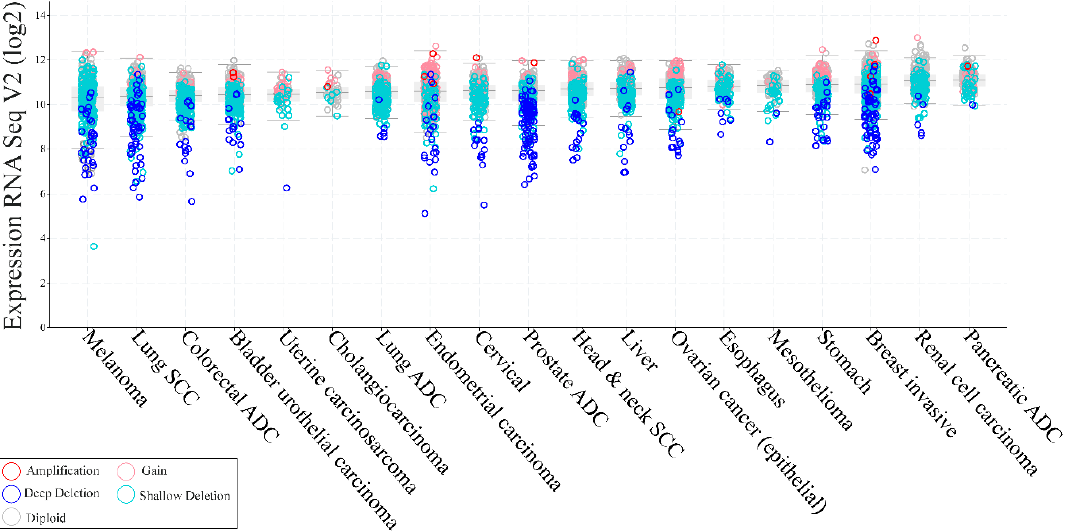
Figure 6. RNA expression levels and copy-number alterations of PTEN across PTEN-altered solid tumors. Each column represents a tumor type from cbioportal.org datasets. Types of alterations are color-coded on the basis of the legend on the bottom. ADC, adenocarcinoma; SCC, squamous cell carcinoma.